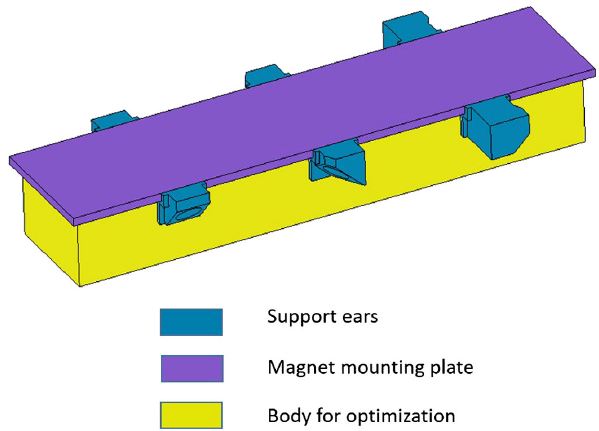
FIG. 2. Model for topological